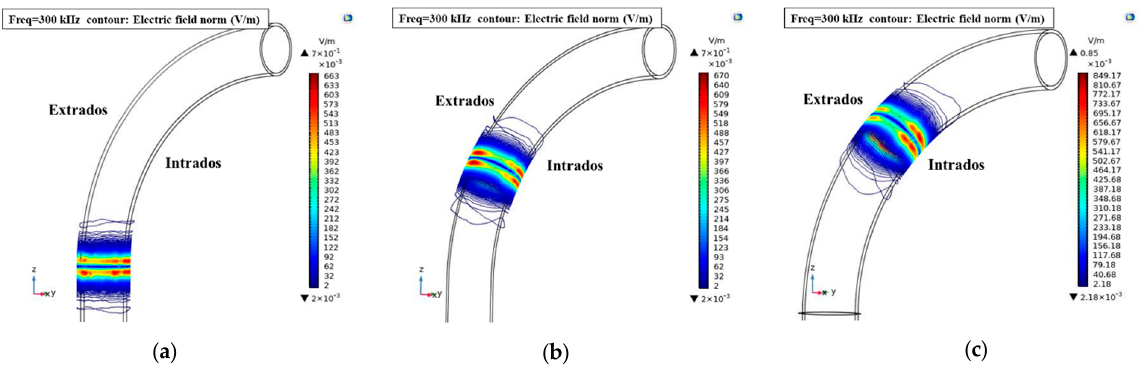
Figure 8. The results of the simulation of the electric field at angle positions: ( a ) 0°, ( b ) 29°, and ( c ) 45°.